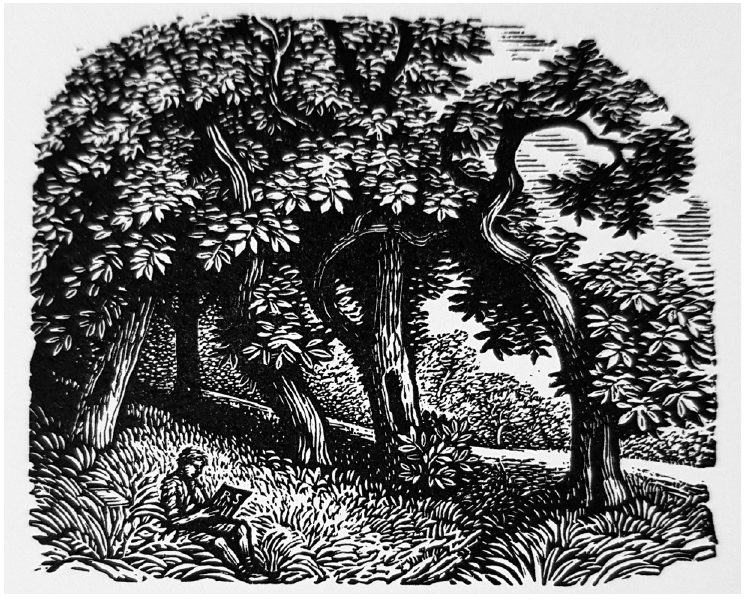
Figure 5 Illustration for Boxwood poem IV. Image courtesy of the Estate of Reynolds